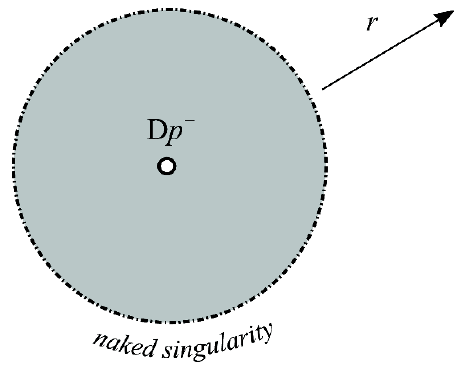
Figure 1 . Negative branes are surrounded by a naked singularity at a (cid:12)nite distance from the brane, forming a \bubble" around the